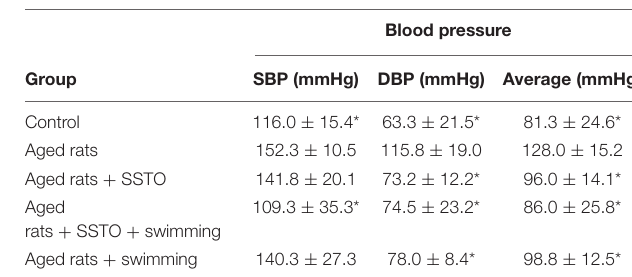
TABLE 2 | Systolic and diastolic blood pressure and mean blood pressure of the rats in this